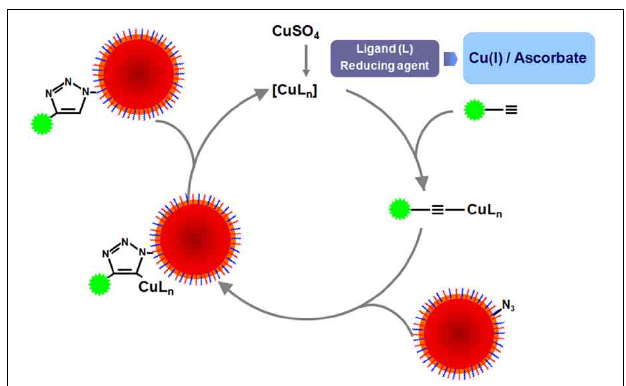
FIGURE 11 | Click chemistry reaction. The copper-catalyzed cycloaddition of azides and alkynes (CuAAC) developed for click chemistry joins an organic azide (N 3 ) and alkyne together producing a mixture of 1,4- and